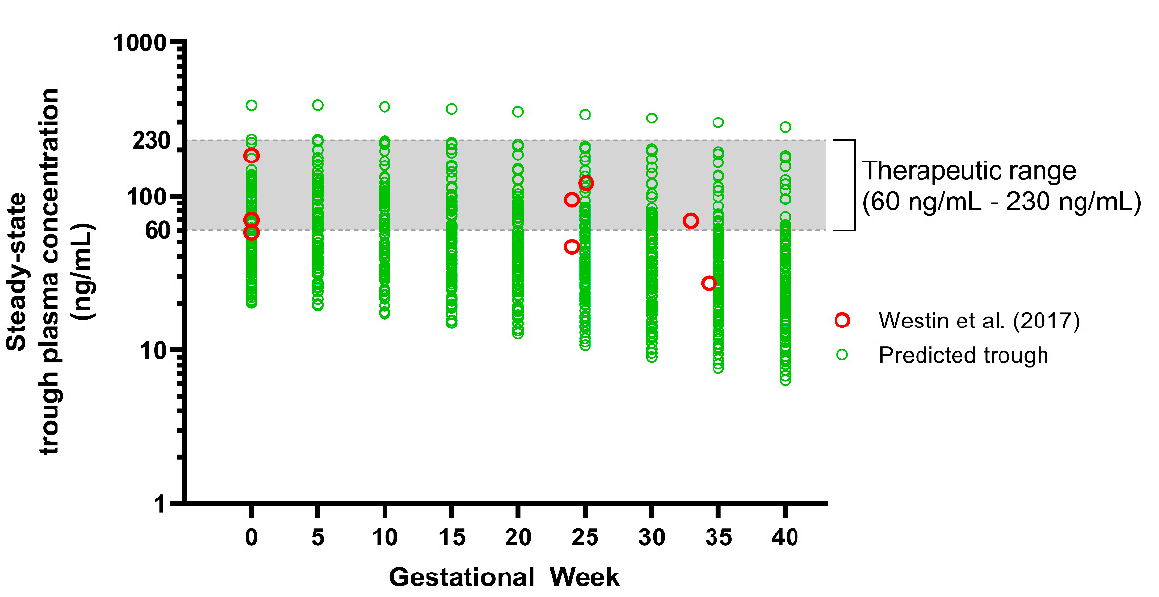
Figure 8. Predicted steady-state C min fluvoxamine maternal concentration. Green, open circles represent the post-dose trough concentration sampled at 24 h post-dose and assembled every 5 GWs throughout the maternity period. Red, open circles represent reported plasma concentrations collected from 3 pregnant women from Westin et al. [18]. ‘0’ refers to the baseline predicted in the non-pregnant female population. The grey shaded region represents the fluvoxamine therapeutic window (TW). Table 4. Predicted fluvoxamine plasma-concentration across the maternity